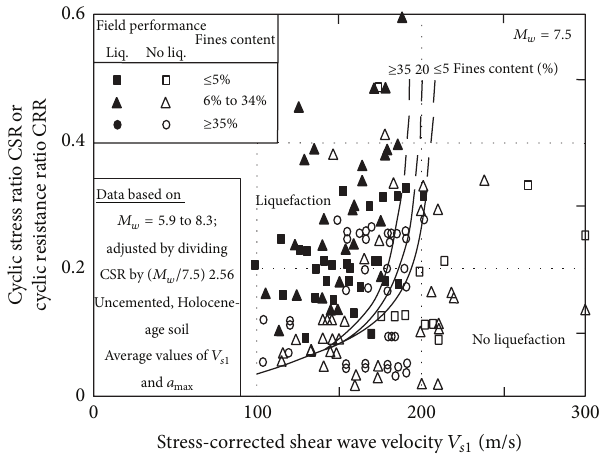
Figure 7: Recommended curves for evaluating CRR from shear wave velocity 𝑉 𝑆 for clean, uncemented soils with liquefaction data from compiled case histories [27].